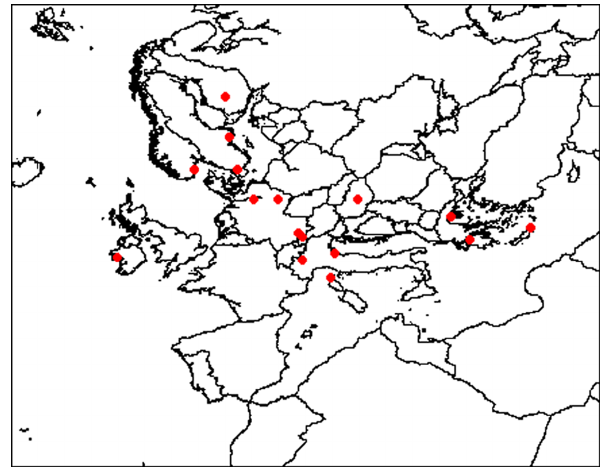
Figure 1. Modeling domain of PMCAMx-UF for Europe. Red dots show the measurement stations of Birkenes (Norway), Hyytiälä (Finland), K-puszta (Hungary), Aspvreten (Sweden), Vavihill (Swe- den), Ispra (Italy), San Pietro Capofiume (Italy), Corsica (France), Patras (Greece), Finokalia (Greece), Thessaloniki (Greece), Mace Head (Ireland), Schneefernerhaus (Germany), Hohenpeissenberg (Germany), Melpitz (Germany), and Waldhof